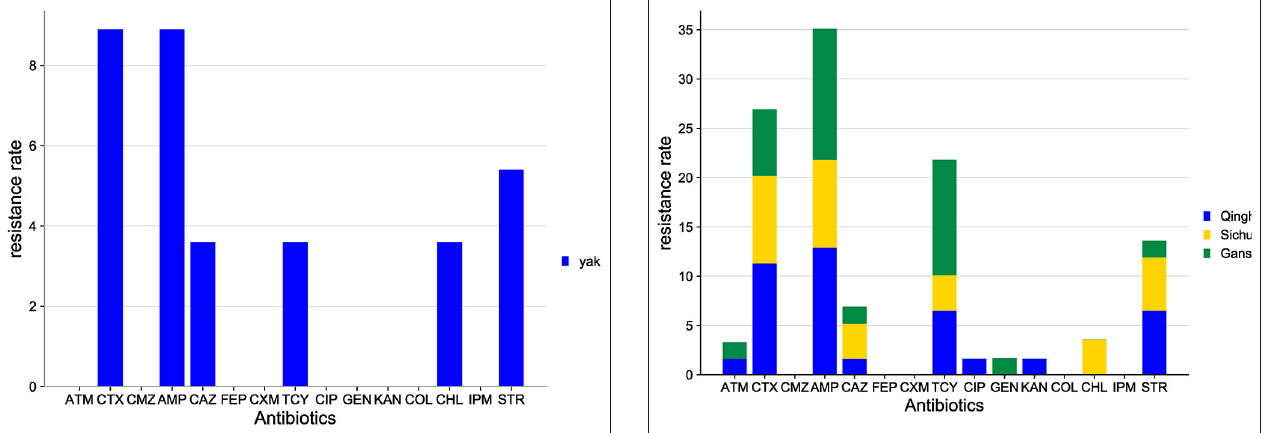
FIGURE 6 | Distribution of antibiotic resistant phenotypes in E. coli from Qinghai.